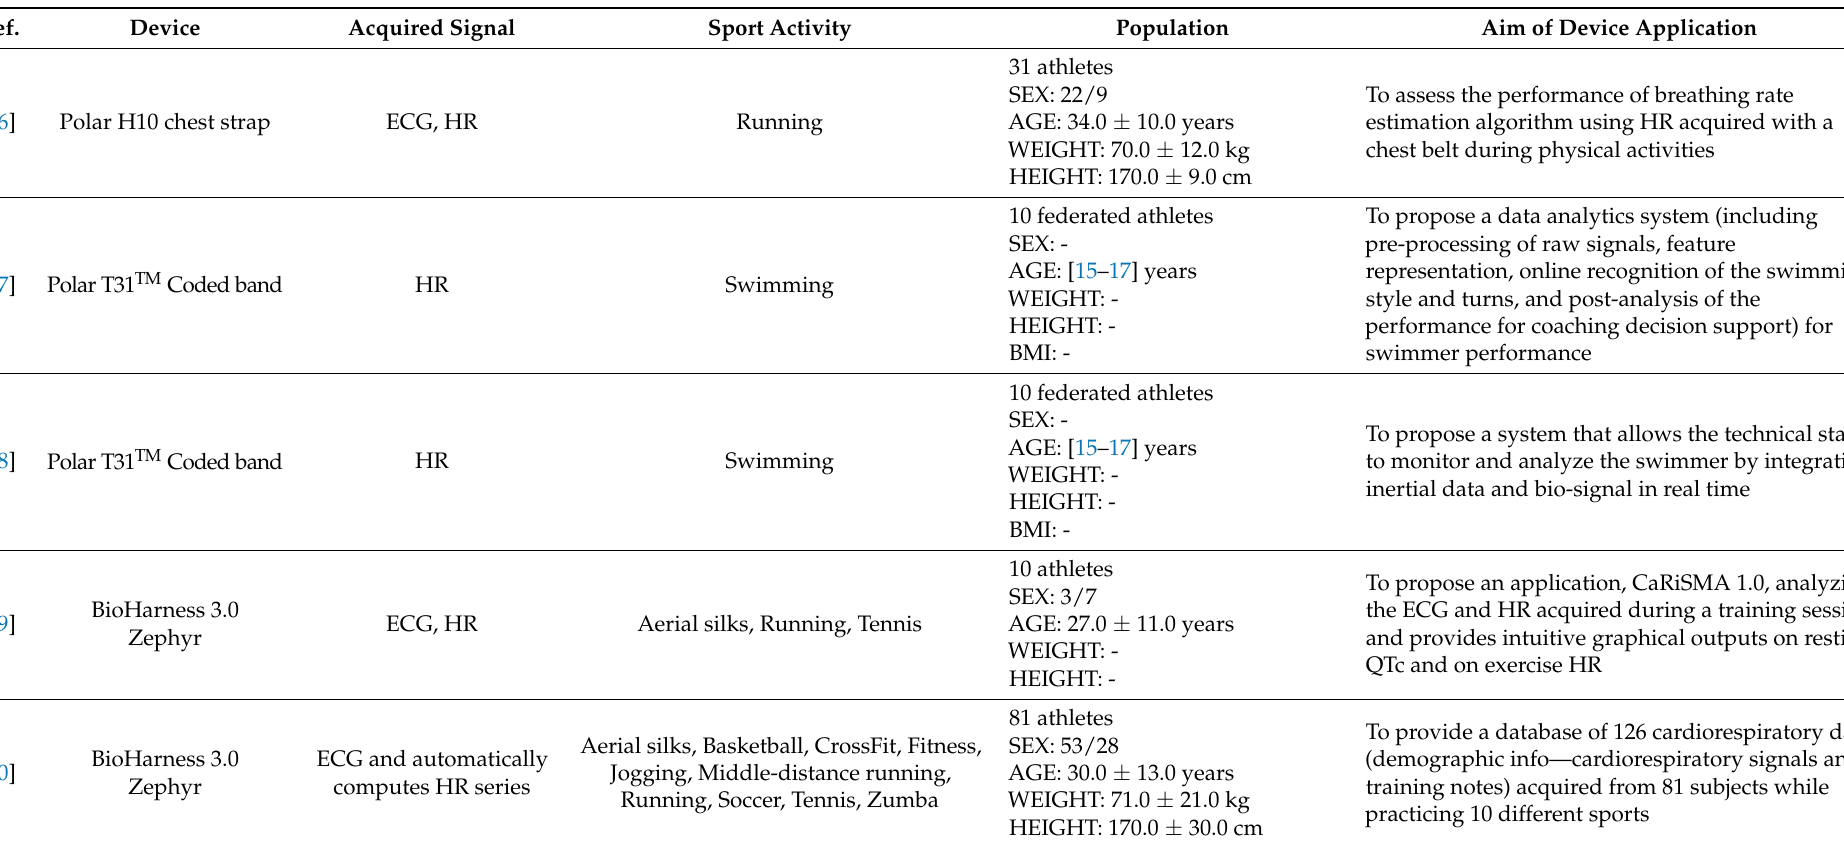
Table 3. Development studies characterized by the used wearable or portable device, the acquired signal (ECG and/or HR), the practiced sport activity, the population characteristics and the aim of device application. Devices are reported with their commercial name and the population characterized in terms of sex (male/female), age, and BMI. If not, present height and weight are reported. Information not available is reported as “-”.